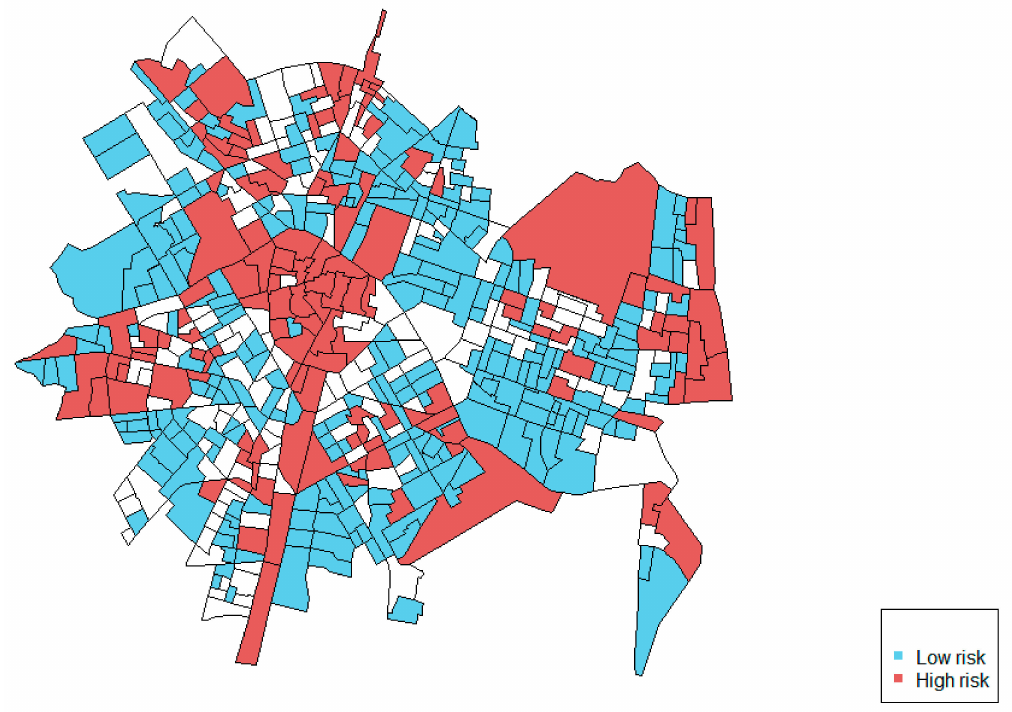
Figure 4. Map of coincident risk